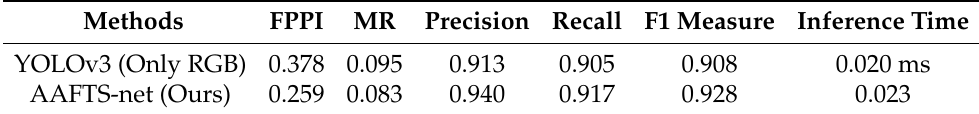
Table 1. Comparison of the results of AAFTS-net and YOLOv3 on RGBD-Humans. Methods